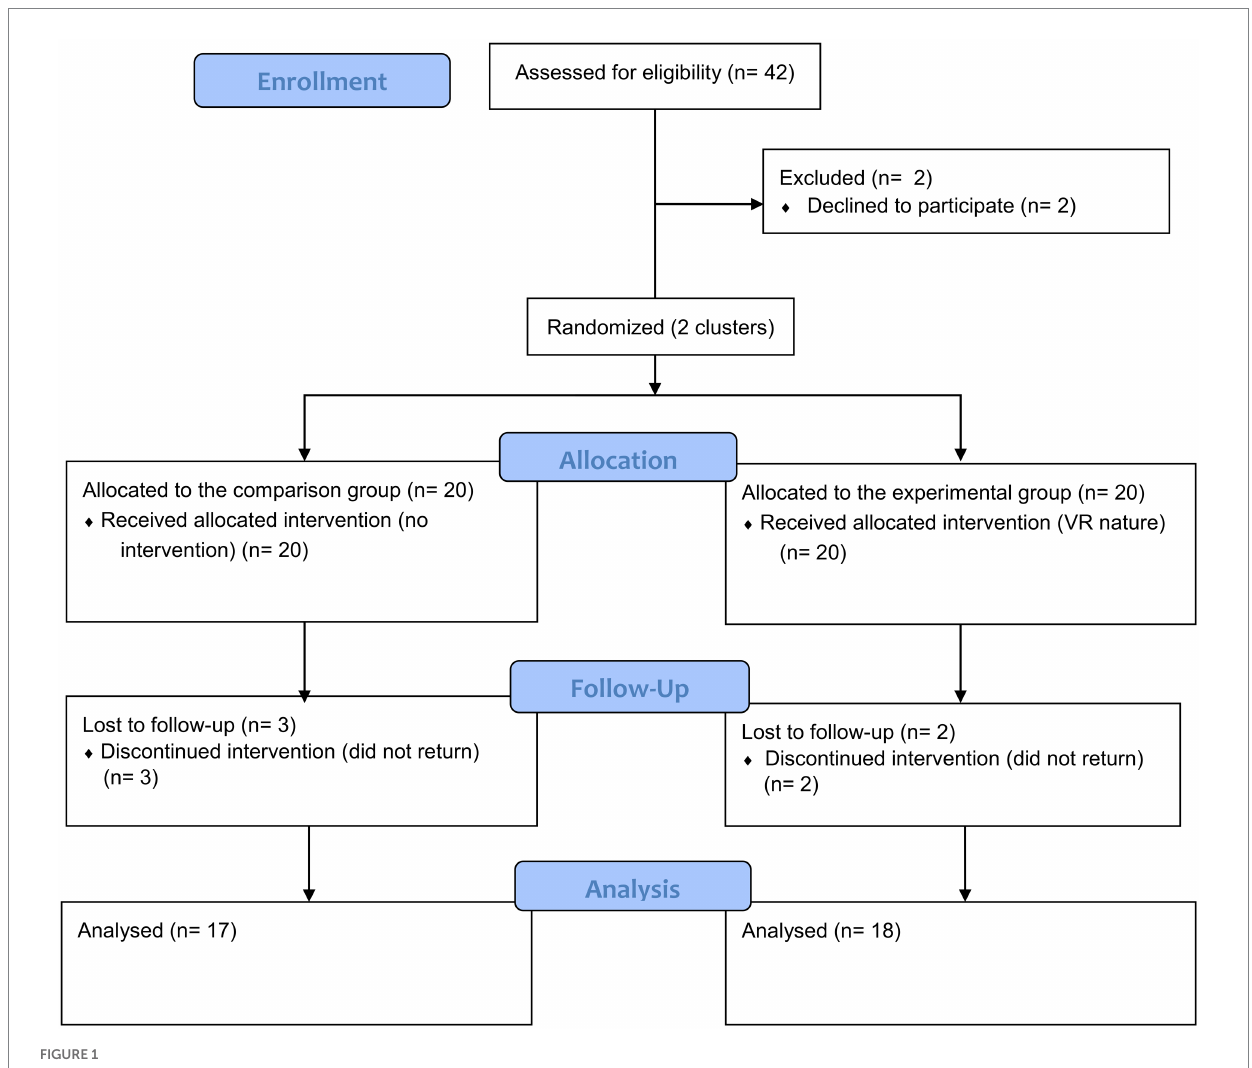
FIGURE 1 Flow diagram detailing the progress of enrolment to analysis.